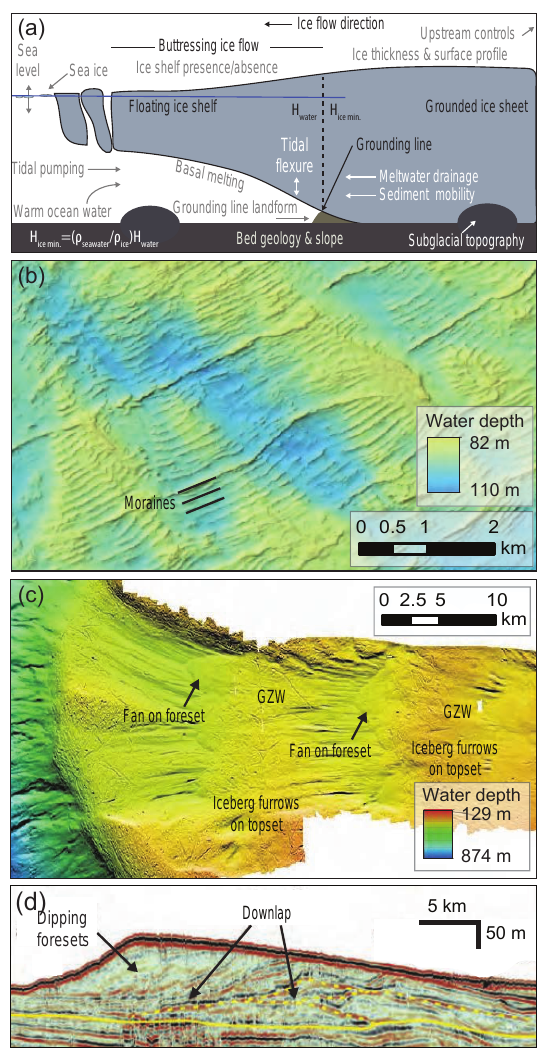
Figure 1. (a) Schematic of a marine-based grounding line en- vironment and processes that can influence grounding line be- haviour. The minimum ice thickness ( H icemin. ) needed for ground- ing is a function of water density ( ρ seawater ) , ice density ( ρ ice ) , and water depth ( H water ) . Examples of grounding line landforms are shown in (b) – (d) . (b) Regularly spaced, small-amplitude reces- sional moraines (de Geer moraines) on the Atlantic Canadian conti- nental shelf (modified from Shaw et al., 2009). (c) Grounding zone wedges in the Kveithola Trough, western Barents Sea overprinted by iceberg furrows and deposited on top of glacial lineations (mod- ified from Rebesco et al., 2011). (d) Dip-oriented acoustic profile across a grounding zone wedge in the Canadian Beaufort Sea show- ing prograding foreset beds that downlap on underlying surfaces (modified from Batchelor et al.,